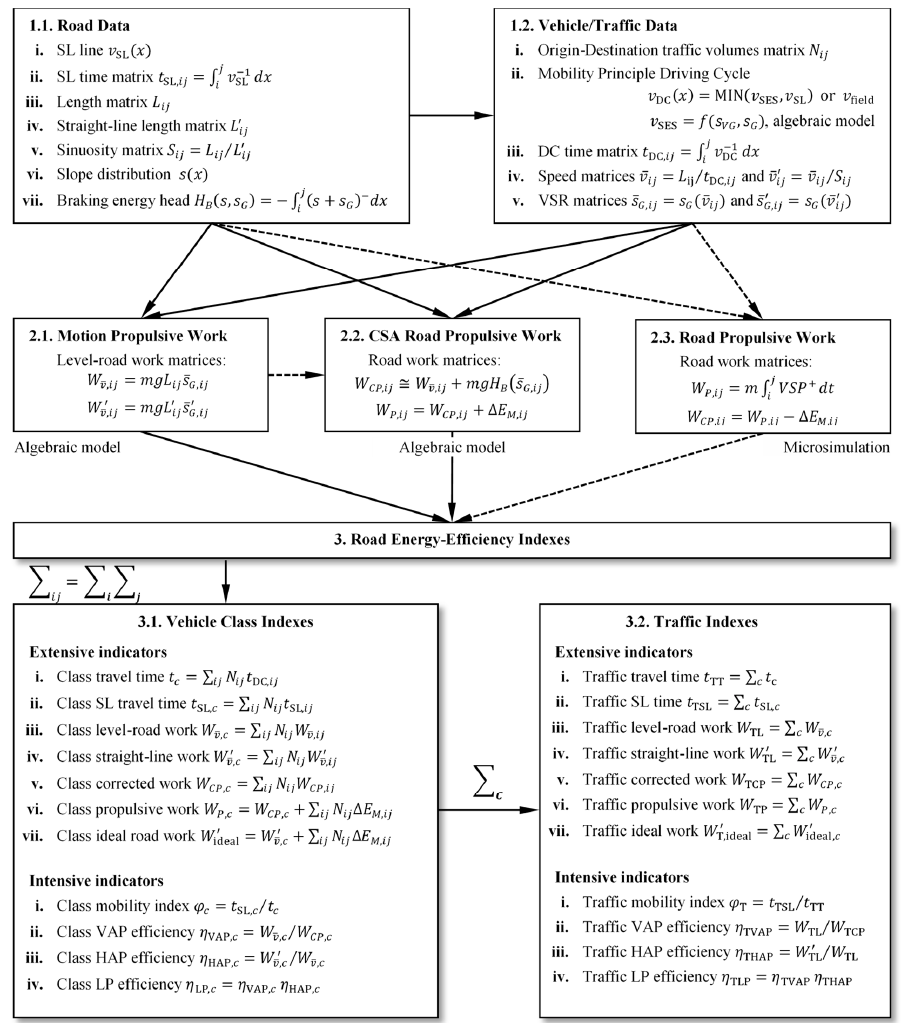
Figure 5. Flow chart of the energy-efficiency rating methodology for free-flow traffic conditions.